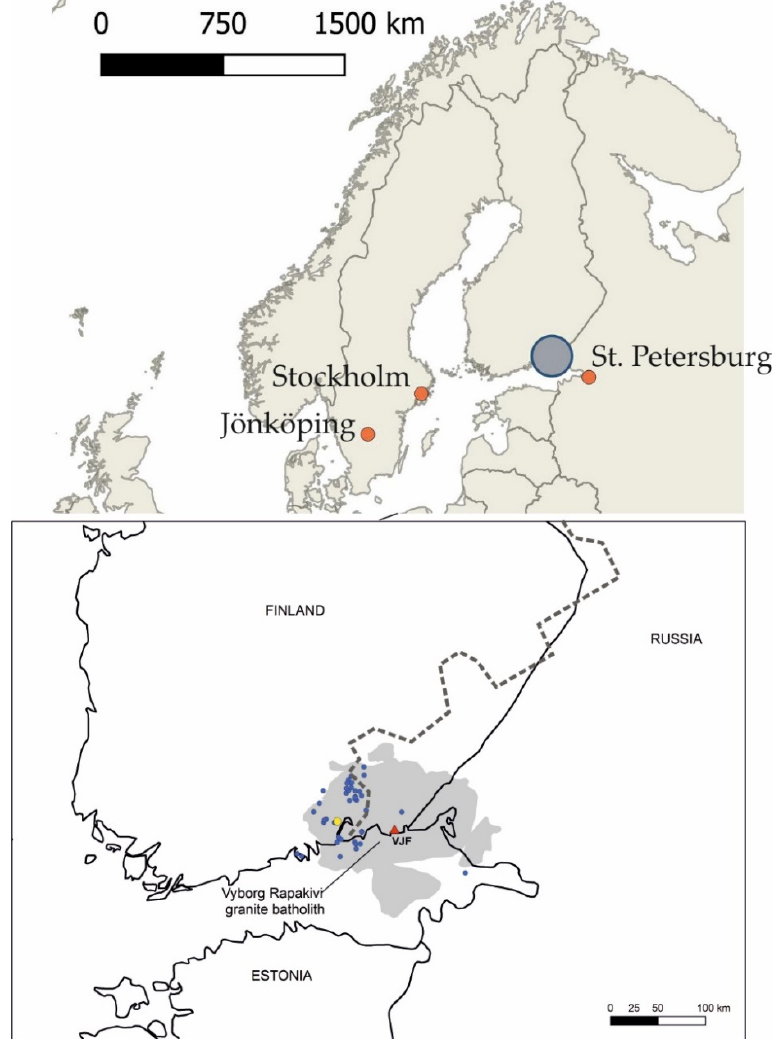
Figure 1. The target region. The lower part shows the area denote by the gray dot in the upper part in more detail. The gray color stands for the Vyborg rapakivi granite batholith. Blue circles show earthquake epicenters between 1610 and 2012. The yellow dot shows the village of Svenskby and the red triangle the seismic station VJF deployed in 2003. The dashed line shows the border at the time of the earthquake sequence, and the continuous lines show current national borders.